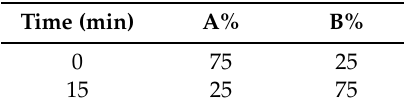
Table 3. Gradient method used at LC-HRMS